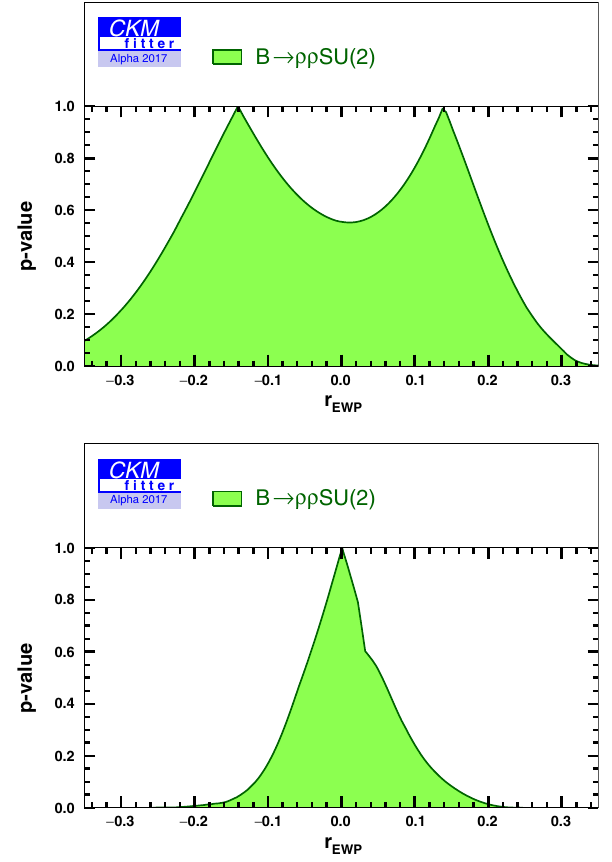
Fig. 13 Constraint on the relative contamination from Δ I = 3 / 2 electroweak penguin r ewp = P + 0 ew / T + 0 from the SU ( 2 ) analysis of B → ππ ( top ) and B → ρρ ( bottom ), obtained by constraining the weak phase α with the indirect determination provided by the global CKM fit [18]. An additional constraint on the strong and electroweak penguin hierarchy has been implemented ( | P + 0 ew | < | P +− | ) in order to single out the solution for α compatible with the indirect determination